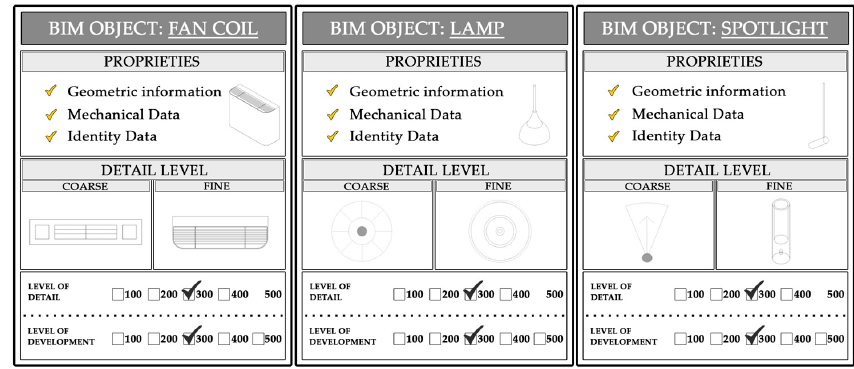
Figure 9. Different detail levels for system objects.